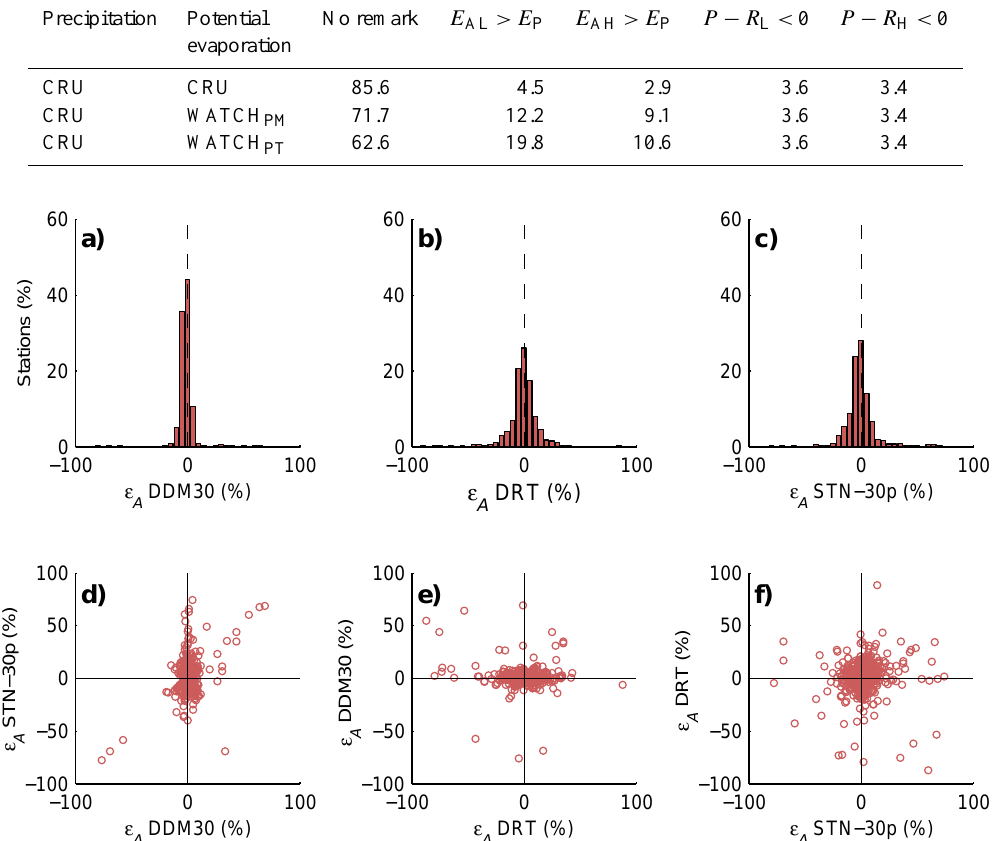
Table 2. Percent of basins (based on the GIS-polygon dataset) exhibiting potential data inconsistencies. Each basin is only accounted for in the worst category that applies to it, e.g. a basin for which the lowest of the actual evaporation estimates exceed the potential evaporation is accounted for in column E AL >E P but not E AH >E P .